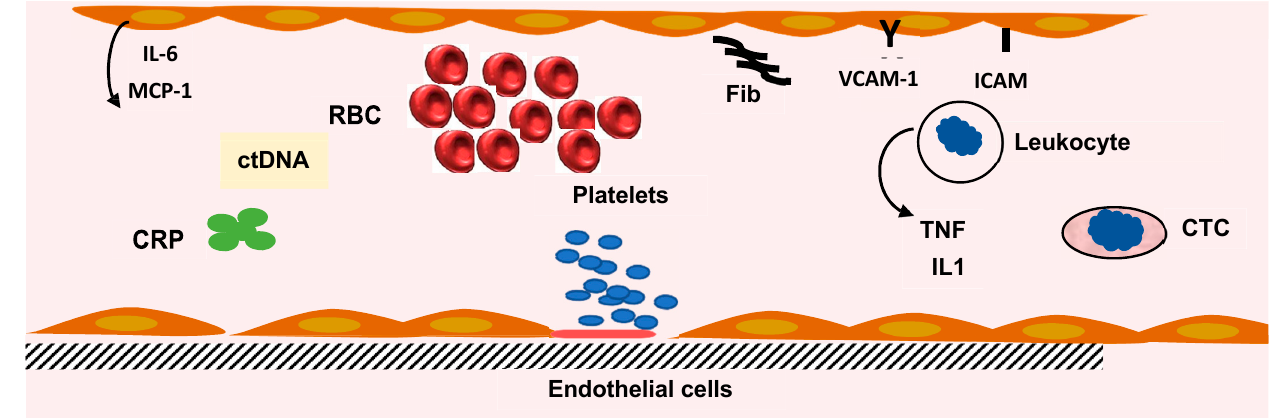
Figure 3. Inflammation and inflammatory markers. The defense mechanism involves leukocytes, platelets, and liver synthesis of proteins. The increase in fibrinogen (Fib) synthesis participates in the abnormal red blood cell (RBC) rheology and the increase in erythrocyte sedimentation rate. C reactive protein (CRP) blood level (pentamer) is increased. Several cytokine levels are elevated. Interleukin-6 (IL-6) is produced by endothelial cells (EC) and liver cells. Macrophage chemoattractant protein-1 (MCP1) is secreted by EC, tumor necrosis factor α (TNF), and interleukin-1 β (IL1) by lymphocytes. The blood levels of cytokines are indicators of the inflammatory reaction induced by colorectal cancer. Circulating tumor cell (CTC) and circulating tumor DNA (ctDNA) can be measured in blood and used as an index of tumor